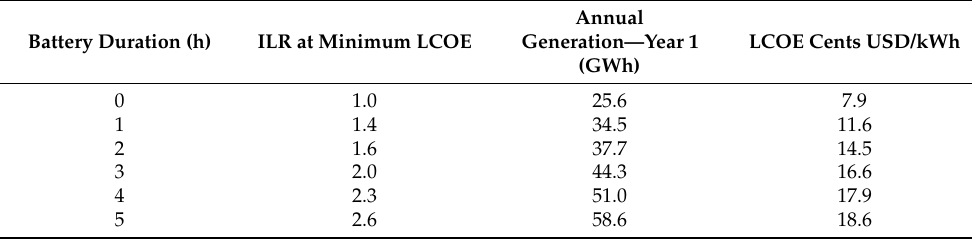
Table 4. Minimum LCOE and corresponding generation with ILR for fixed-tilt